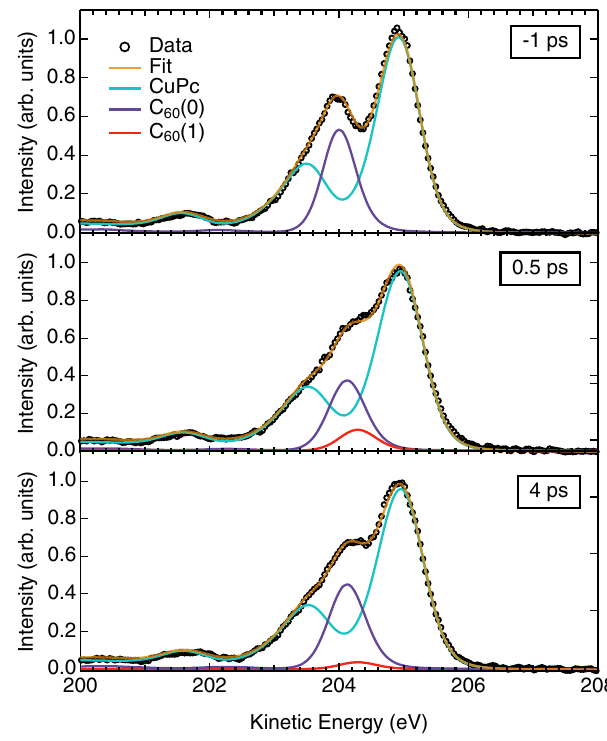
Fig. 4 Representative results of the global fi t shown in Fig. 3 for three different pump – probe delays. Black symbols represent the measured C 1 s spectra of the CuPc:C 60 heterojunction, orange lines the best fi t. The turquoise, purple, and red solid lines show the fi t components derived from the pristine material spectra as indicated. For positive delays, the total C 60 signal splits into an unperturbed component C 60 (0) and a new component C 60 (1) that is shifted to higher kinetic energies by ~160 meV. This shift of the C 60 (1)-C 1 s photoline is associated with increased screening of the core hole by additional charge density in the vicinity of the core-ionized